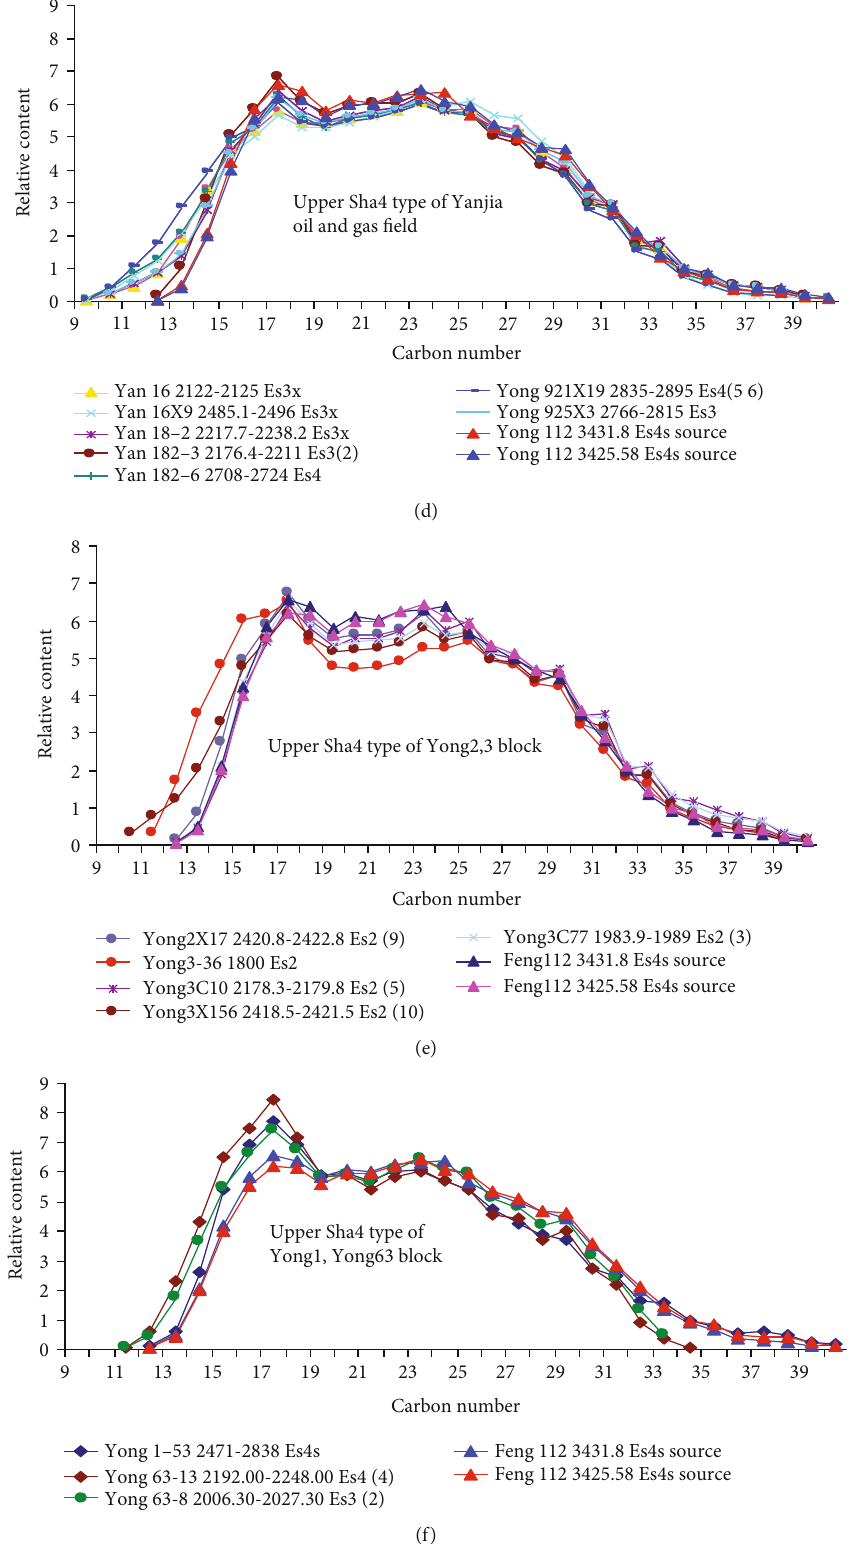
Figure 2: Comparison diagram of carbon number distributions in some crude oil and hydrocarbon source rocks in the study area of n-